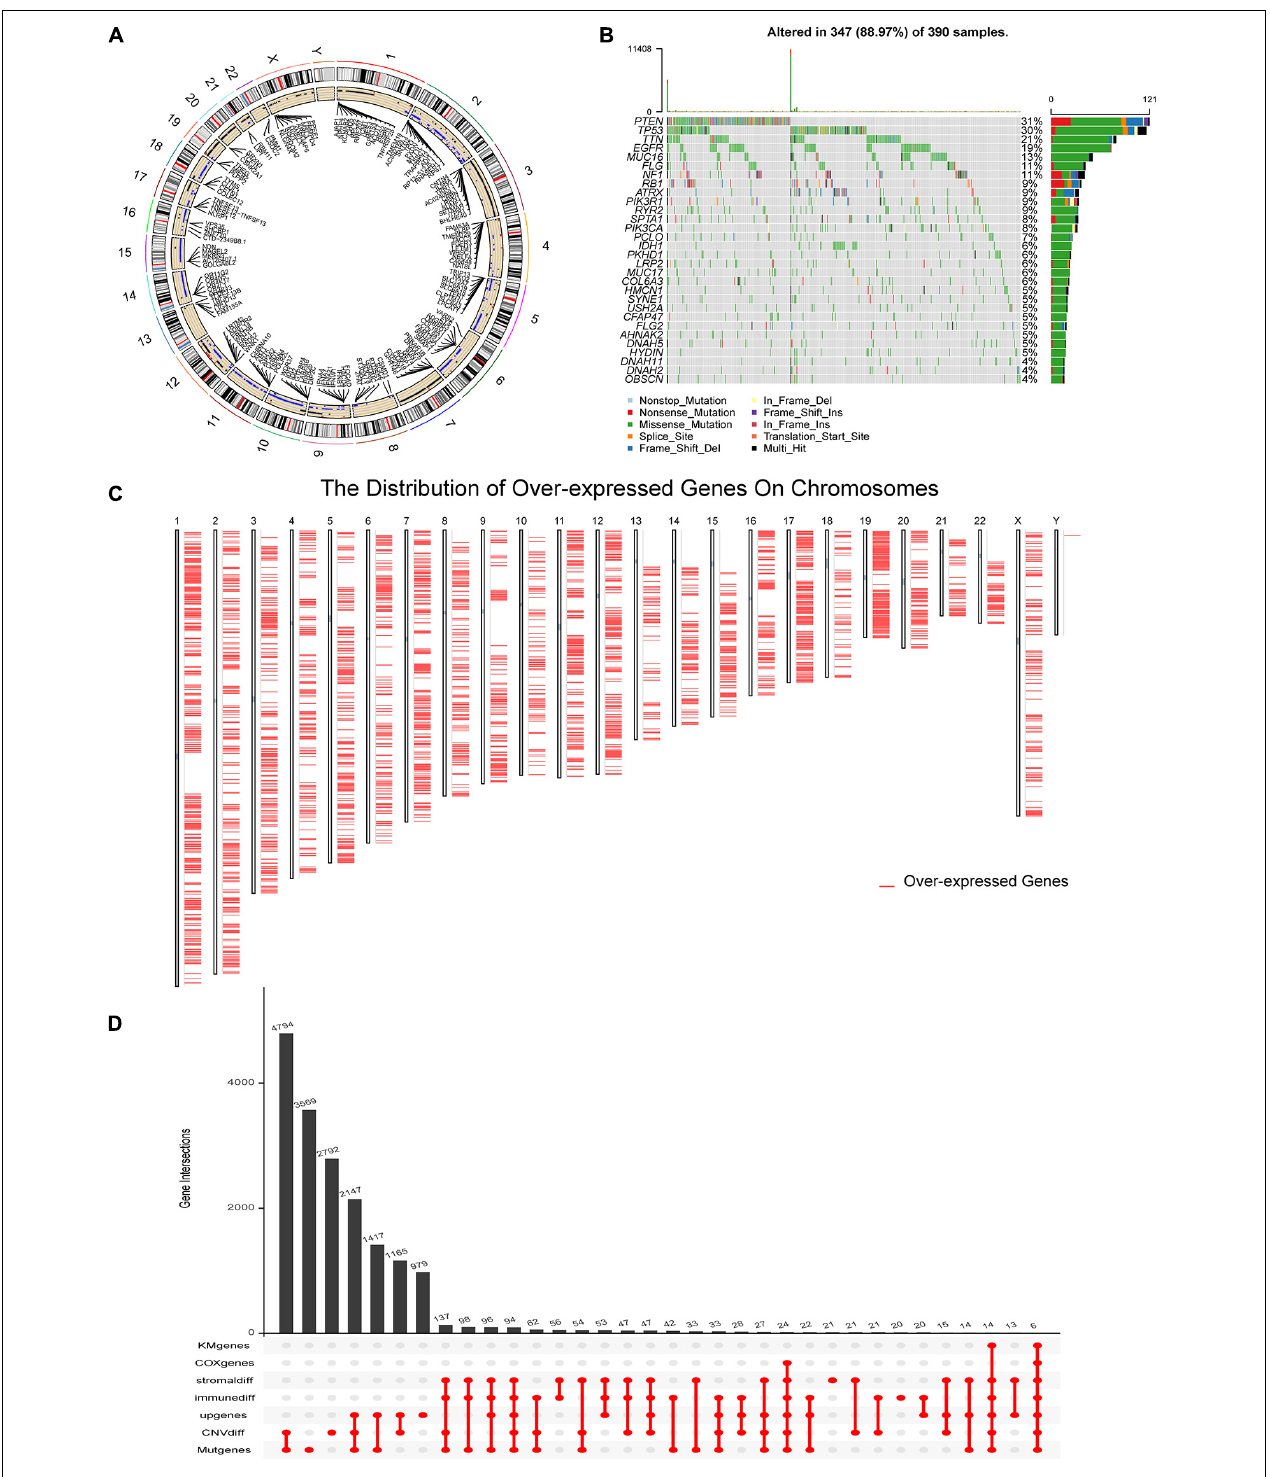
FIGURE 1 | Identification of potential glioblastoma (GBM) vaccine mRNA antigens. (A) The chromosomal distribution of the genes with copy number variant (CNV) in GBM. (B) Waterfall plot of the distribution of the top 30 mutant genes in GBM. (C) Overexpressed genes and the location of the corresponding chromosome according to Gene Expression Profiling Interactive Analysis (GEPIA) dataset. (D) An Upset plot displays the intersections of genes screened under different conditions. GBM, glioblastoma; geneMut, mutant genes; CNVdiff, genes with different copy number variation; upgenes, upregulated genes in GBM; immunediff, differentially expressed genes among low and high immune score groups; stromaldiff, differentially expressed genes among low and high stromal score groups; COXgenes, the genes with P -value less than 0.05 in univariate Cox analysis; and KMgenes, the genes with P -value less than 0.05 in K-M survival analysis.